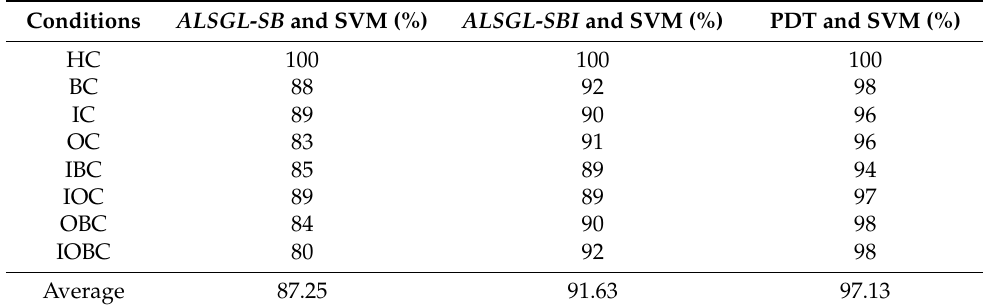
Table 4. Average accuracies of crack type diagnosis using the combined ALSGL-SB and SVM, ALSGL-SBI and SVM, and PDT and SVM approaches .